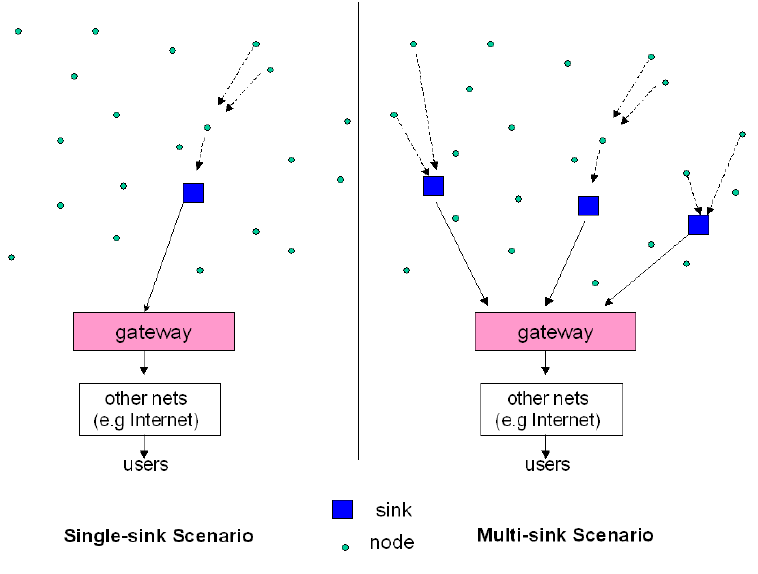
Figure 1. Left part: single-sink WSN. Right part: multi-sink